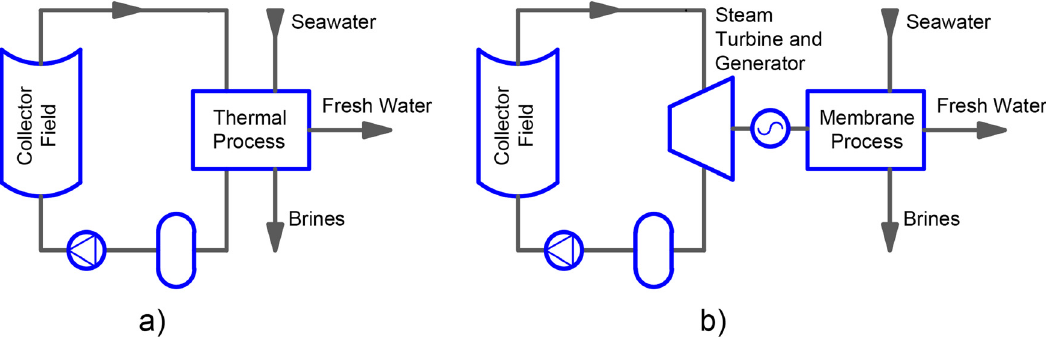
Figure 15: General schematic diagram for desalination: ( a ) phase change, ( b ) single phase.